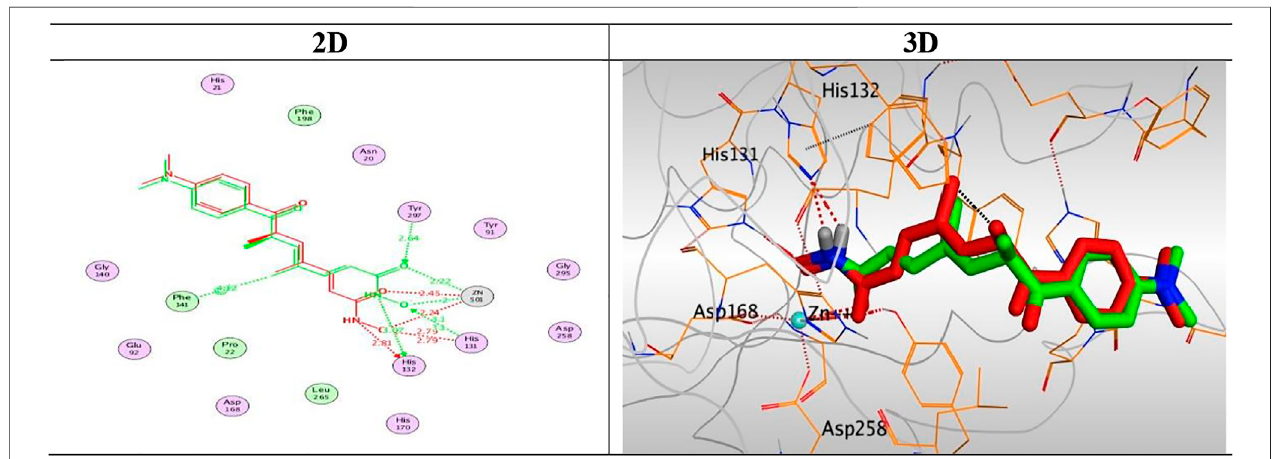
FIGURE 6 | 2D and 3D representations for the redocked co-crystallized TSA antagonist inside the HDAC receptor pocket.